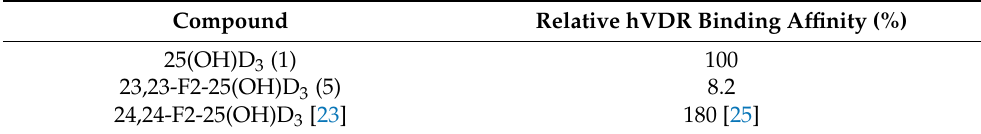
Table 2. Relative hVDR binding affinity of 23,23-F 2 -25(OH)D 3 ( 5 ).